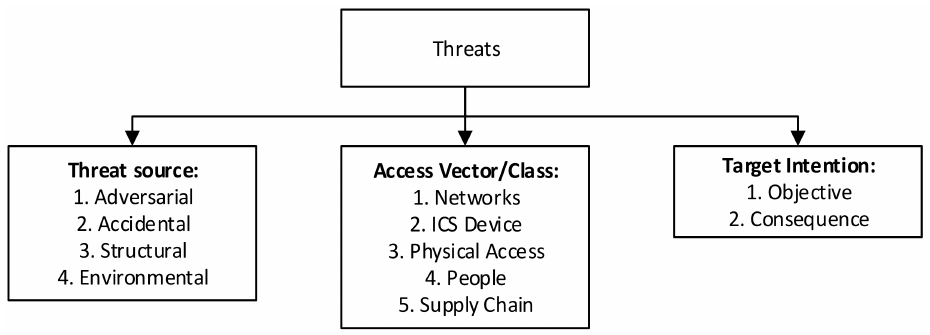
Figure 7. Threat taxonomy [19].